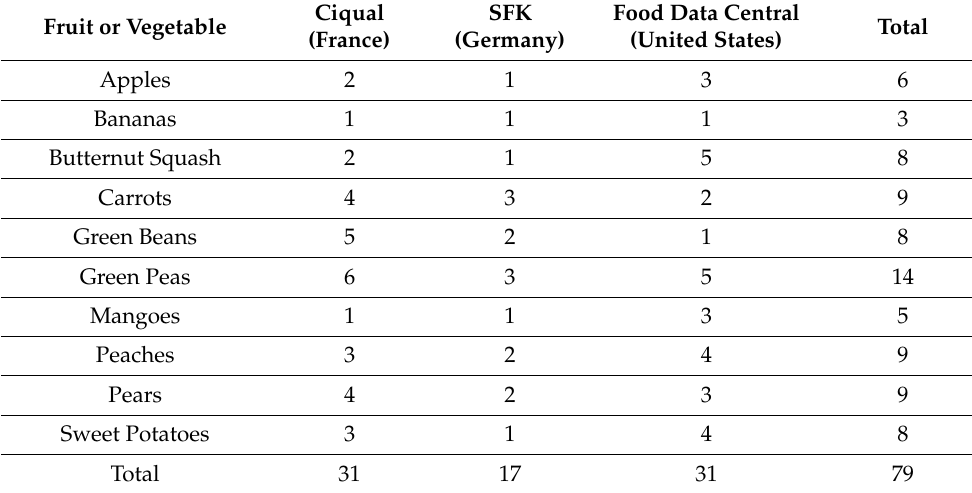
Table 2. Food profile count for each fruit and vegetable by country-specific food composition